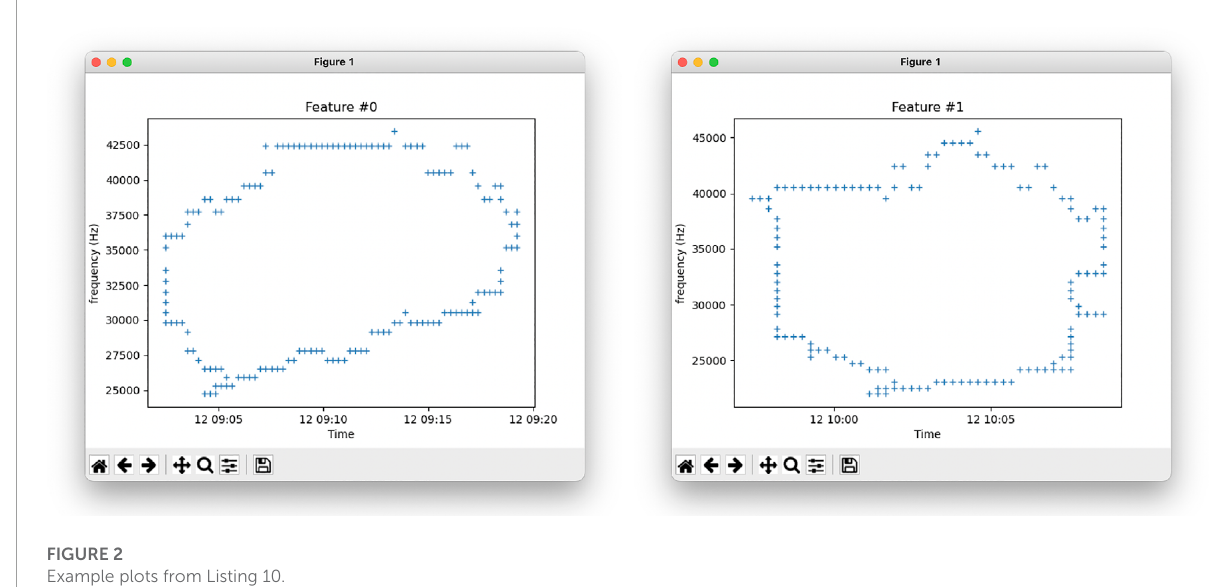
FIGURE 2 Example plots from Listing